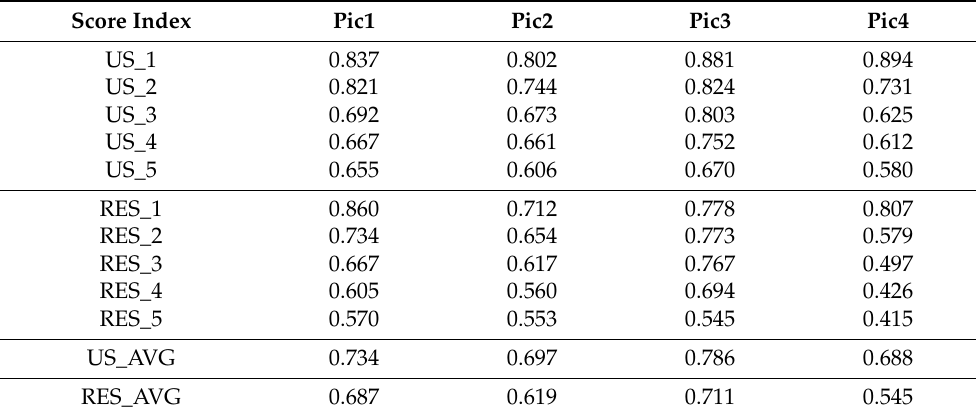
Table 3. Similarity score of trademarks in the same